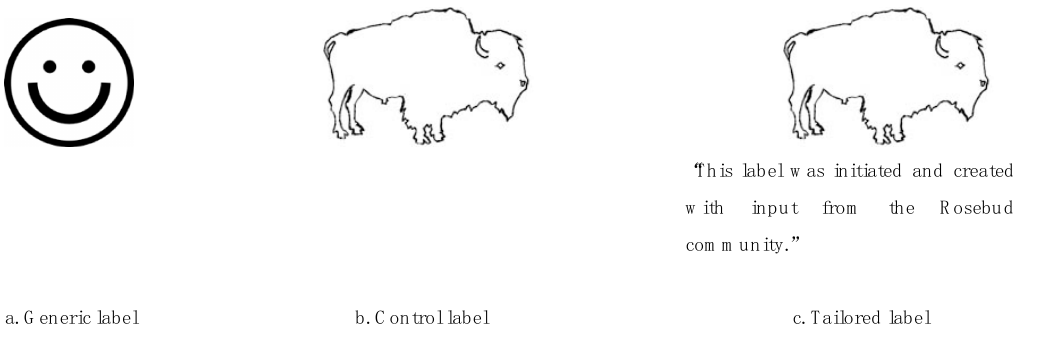
Figure 1. The three versions of the healthy food labels observed by choice experiment participants.